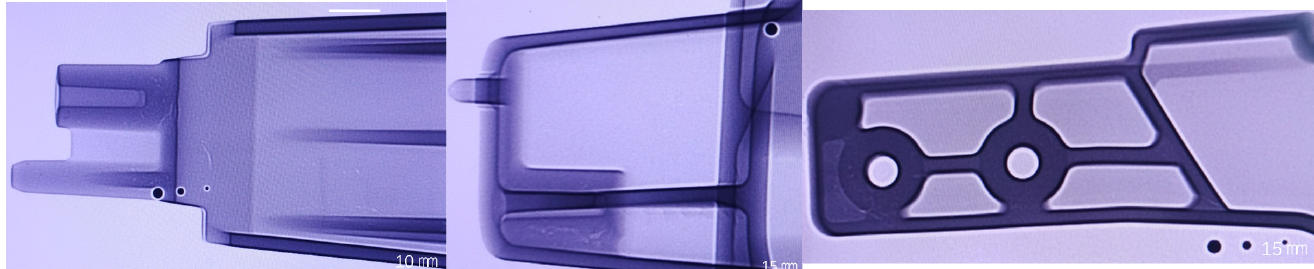
Table 7. Mechanical properties before and after optimization.